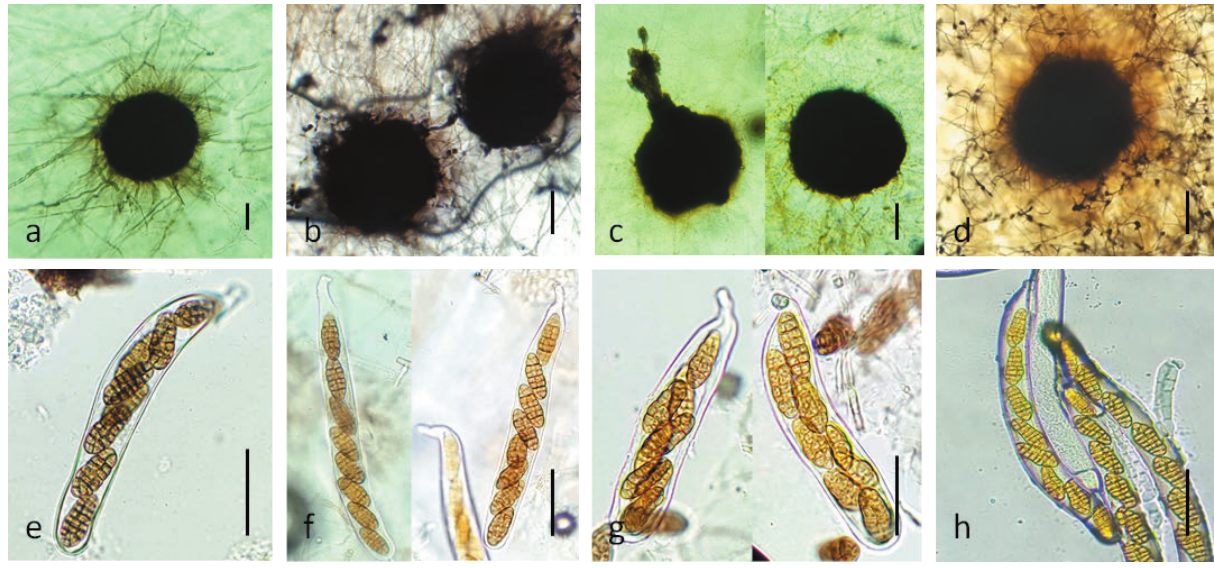
Figure 5. Stemphylium spp. ascoma, asci and ascospores of teleomorph stages developed on potato carrot agar after 1 to 5 weeks incubation at room temperature. Stemphylium eturmiunum (Pleospora eturmiuna) NB714 (a and e); S. vesicarium (Pleospora herbarium) NB654 (b and f); S. gracilariae NB696 (c and g); and S. lycii NB683 (d and h). Bars = 100 µm (a–d) and 50 µm